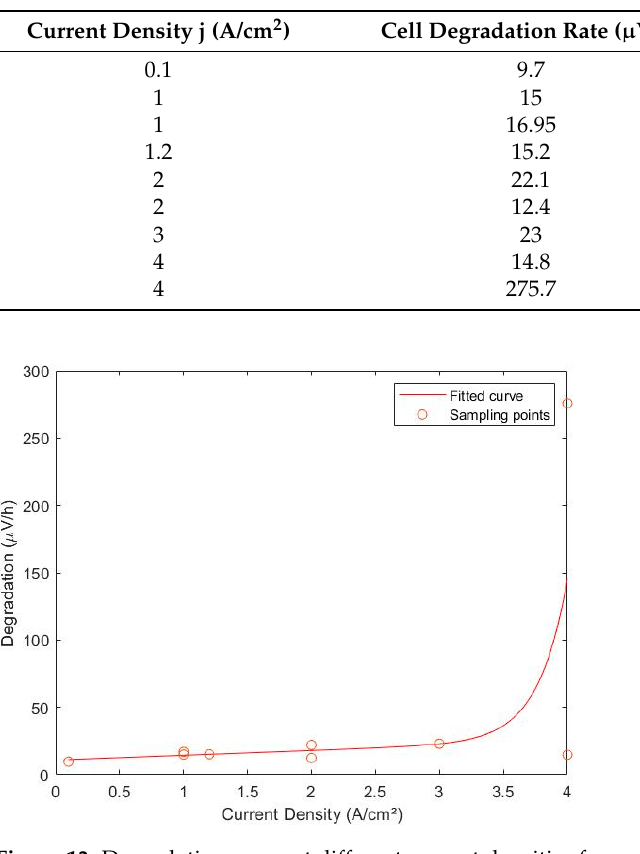
Figure 13. Degradation curve at different current densities for an ELY. Table 2. Sampling points for the generation of the degradation curve for an ELY.